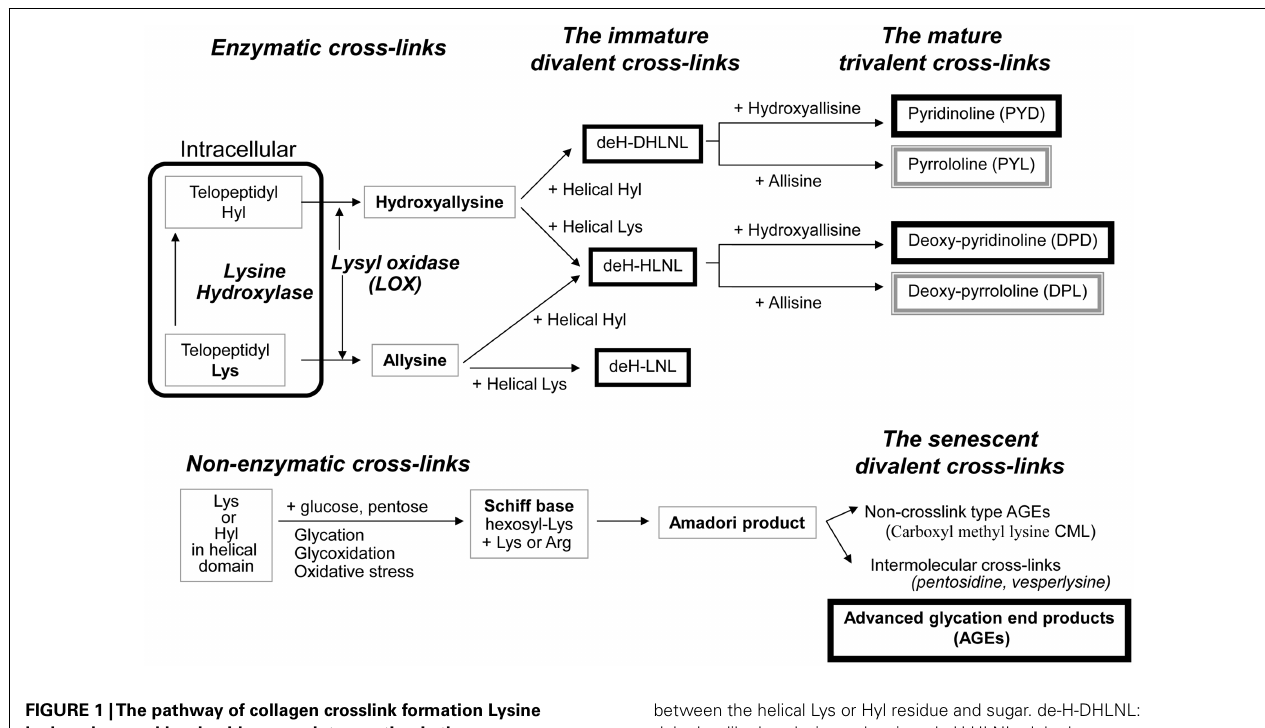
FIGURE 1 |The pathway of collagen crosslink formation Lysine hydroxylase and lysyl oxidase regulate reaction is the first step or enzymatic cross-linking .The first step for AGEs formation is the non-enzymatic glycation, oxidation, or glycoxidation